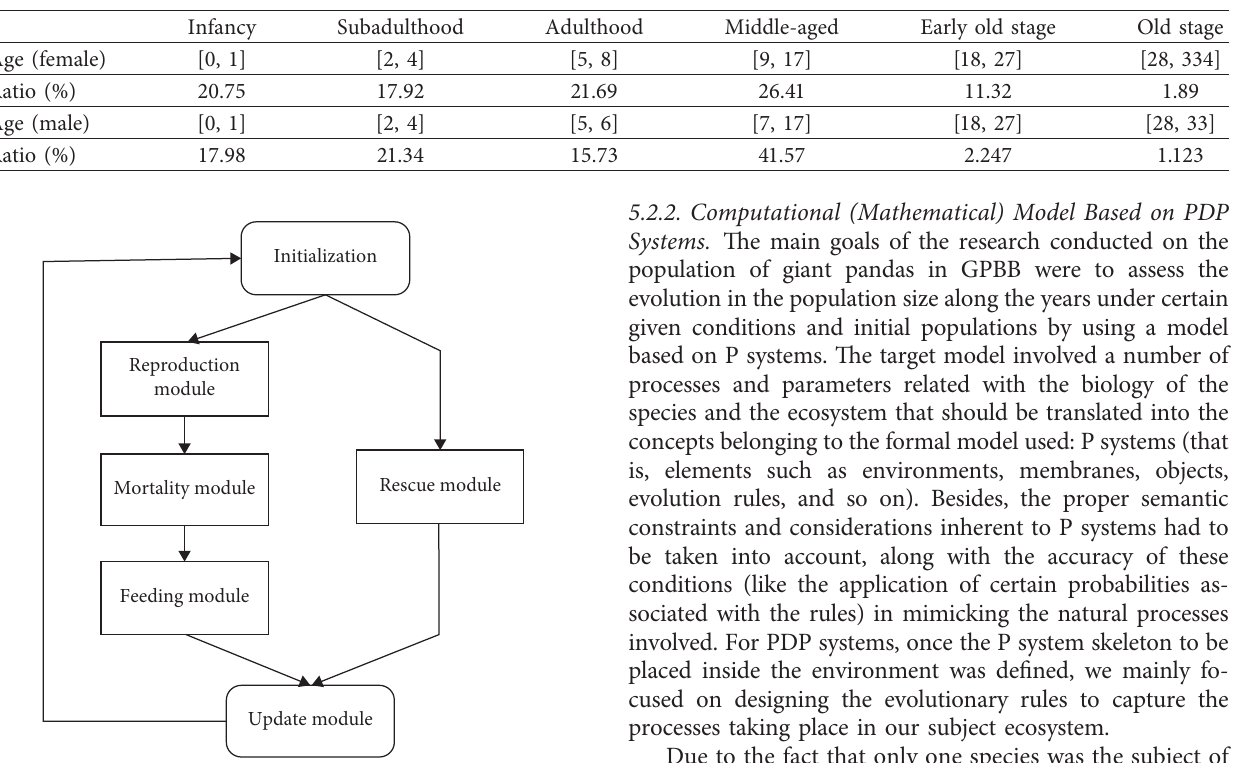
Table 2: Age structure of captive giant pandas in 0–33 years.